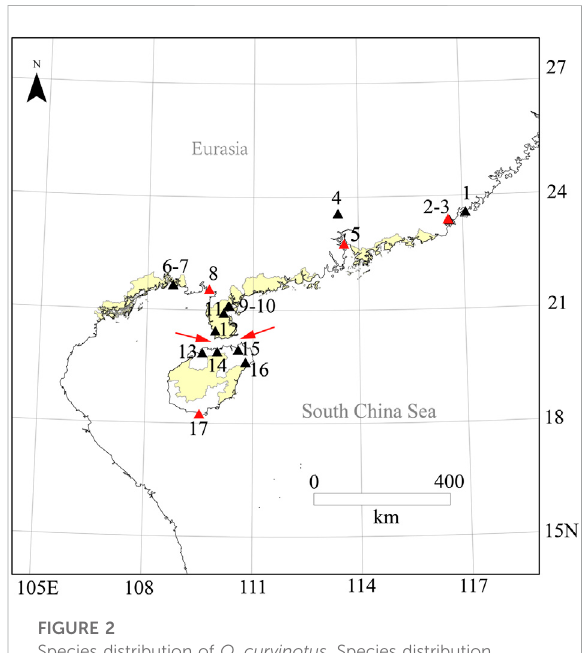
FIGURE 2 Species distribution of O. curvinotus . Species distribution map for O. curvinotus and some new investigation sites; 1, Raoping; 2, Dahao; 3, Niutianyang (ST); 4, Conghua; 5, Nansha (JWM); 6, Zhonggui; 7, Yamchow; 8, Gaoqiao (GQ); 9, Huguang; 10, Donghai dao; 11, Fucheng; 12, Leizhou; 13, Lingao County; 14, Chengmai; 15, Dongzhaigang; 16, Wenchang; 17, Sanya (SY); The location IDs are in common with Supplementary TableS2;Fourcollectionsitesof O.curvinotus forWGSaremarked with red triangles. The red arrow refers to the Qiongzhou